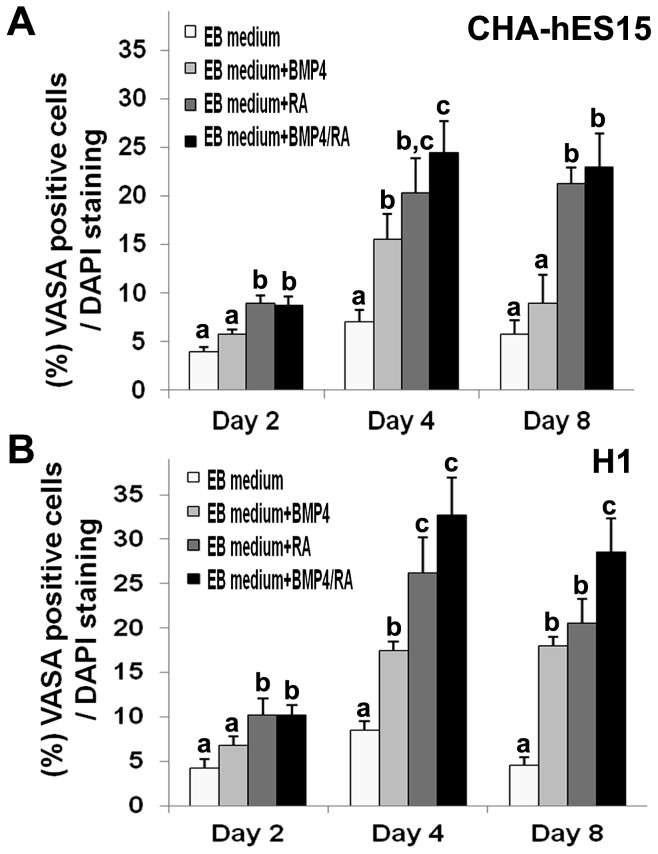
Graphic representations of stained VASA-positive cells.Percentage of VASA-positive cells in EBs derived from CHA-hES15 and H1 hESC lines treated with EB medium (non-treated), RA, BMP4 or RA+BMP4 for 2–8 days. RA: retinoic acid; BMP4: bone morphogenetic proteins 4. Note:
a
vs
b
vs
c, p<0.05.